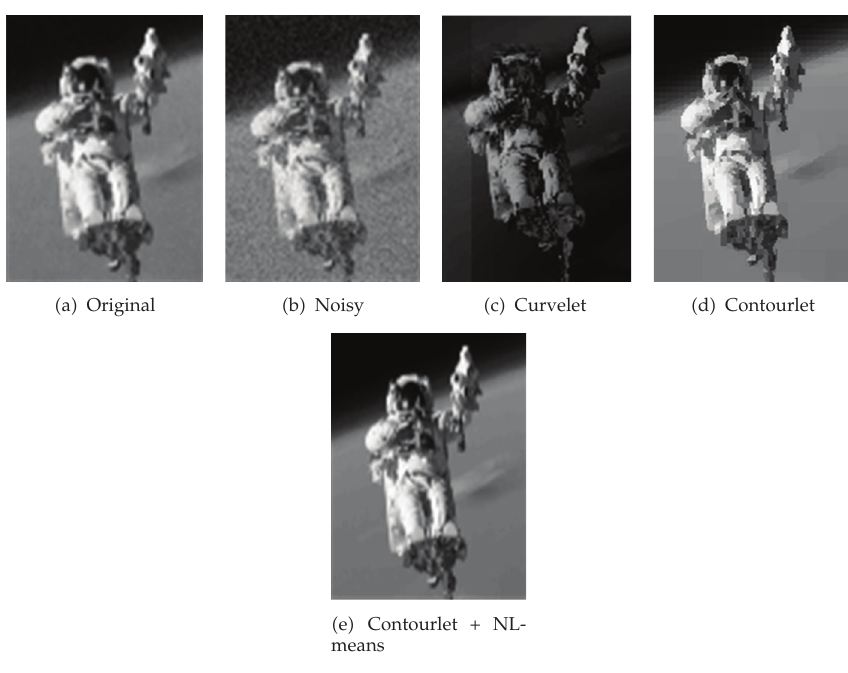
Figure 8: Process results for image